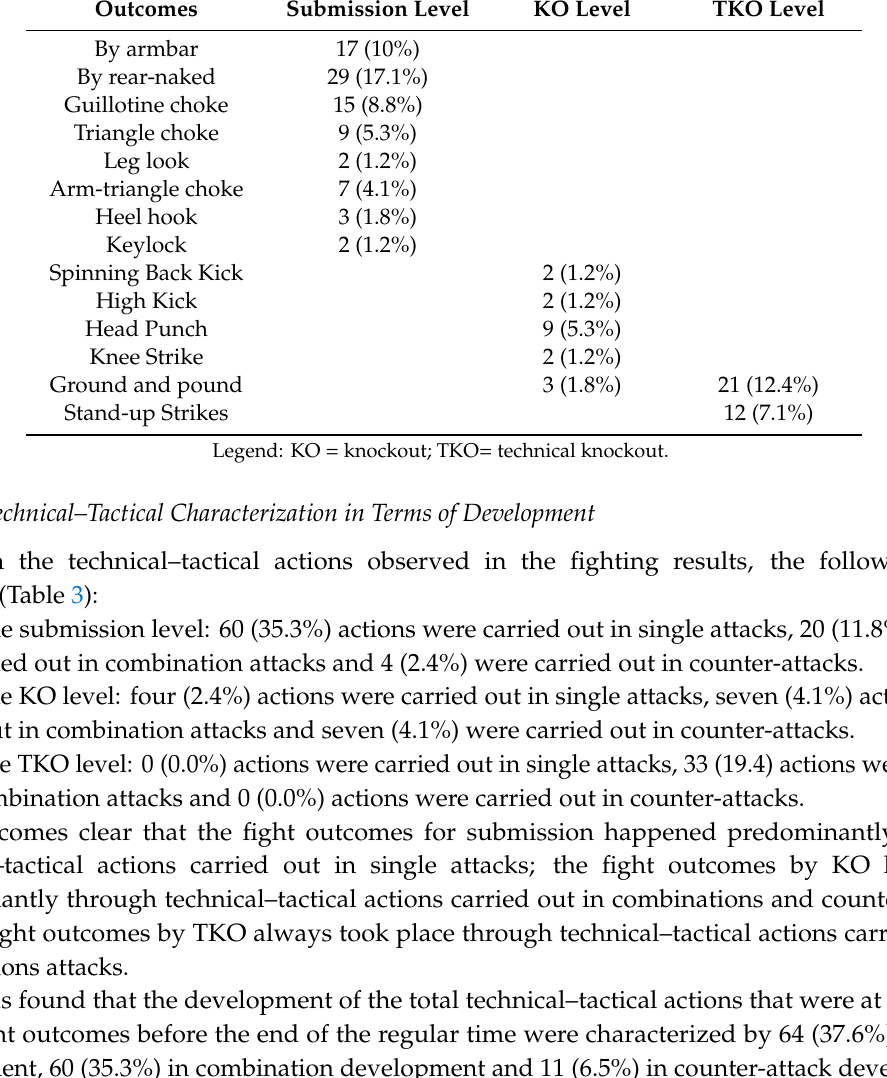
Table 2. Fight outcomes’ characterization in terms of the inherent technical–tactical actions. Outcomes